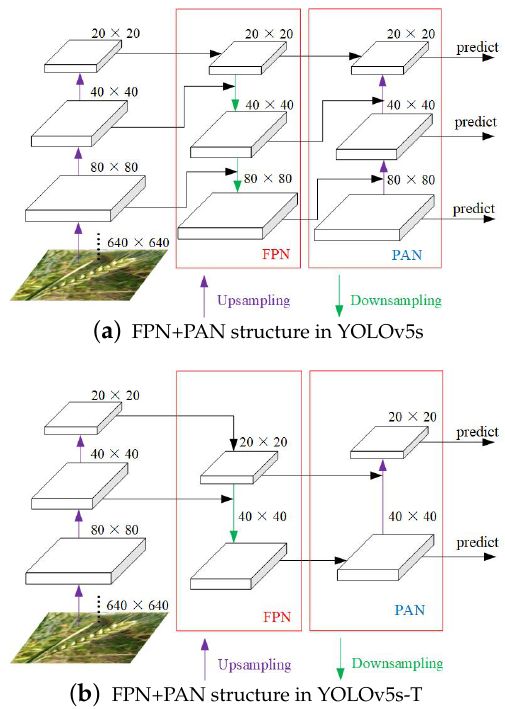
Figure 6. FPN+PAN